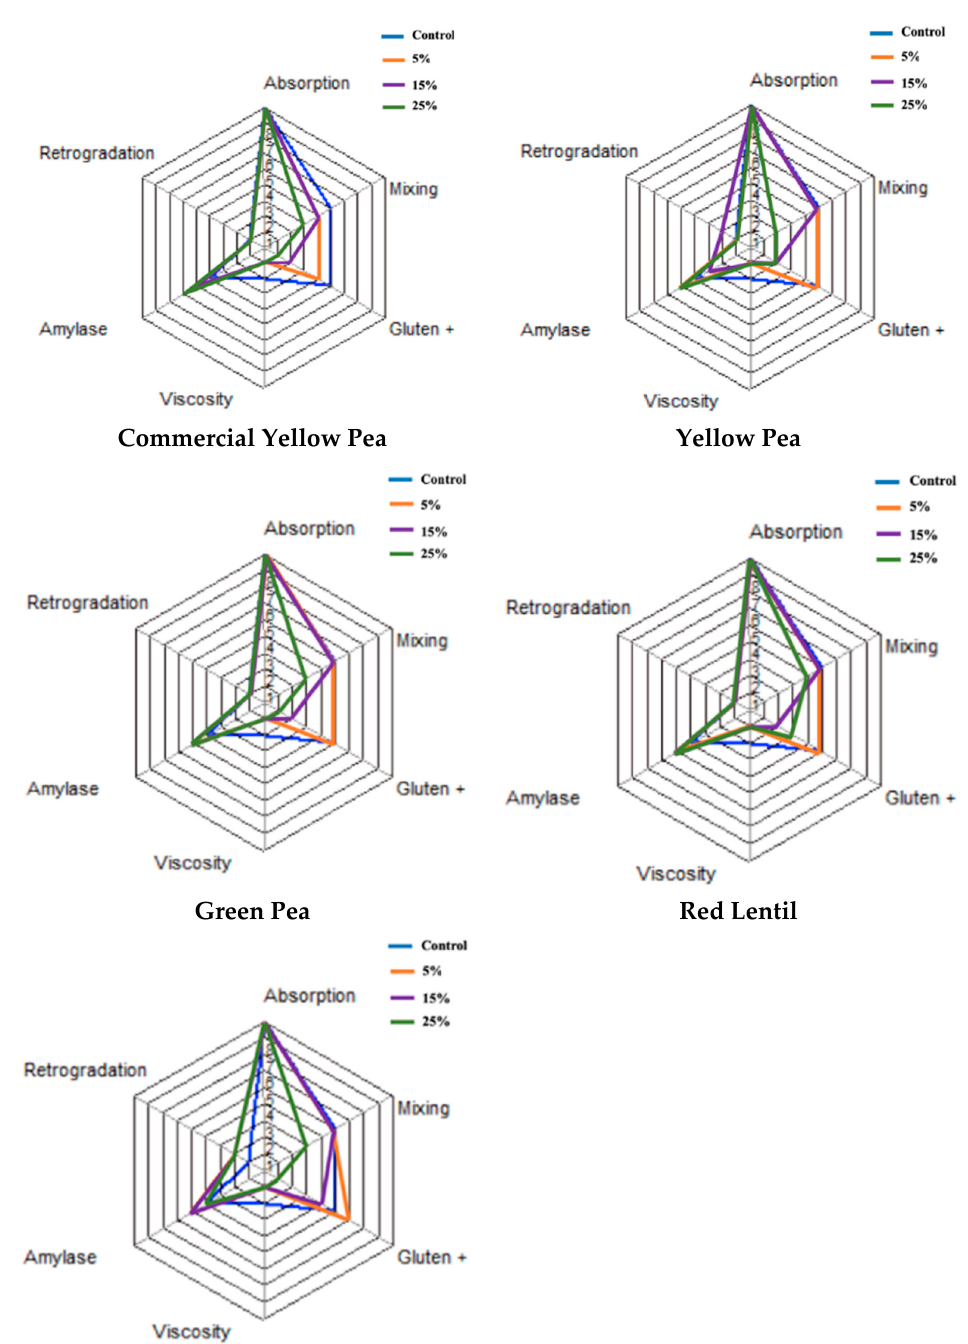
Figure 3. Mixolab index of the whole wheat/pulse flours.